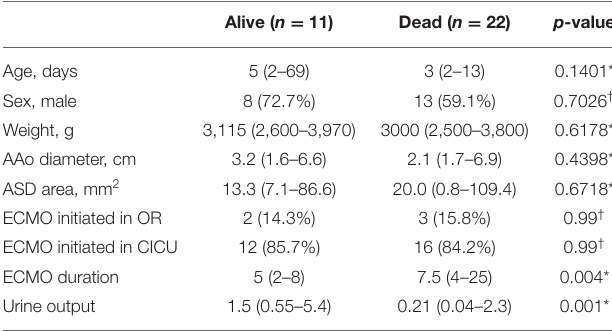
TABLE 1 | Comparison of patient characteristics between alive and dead